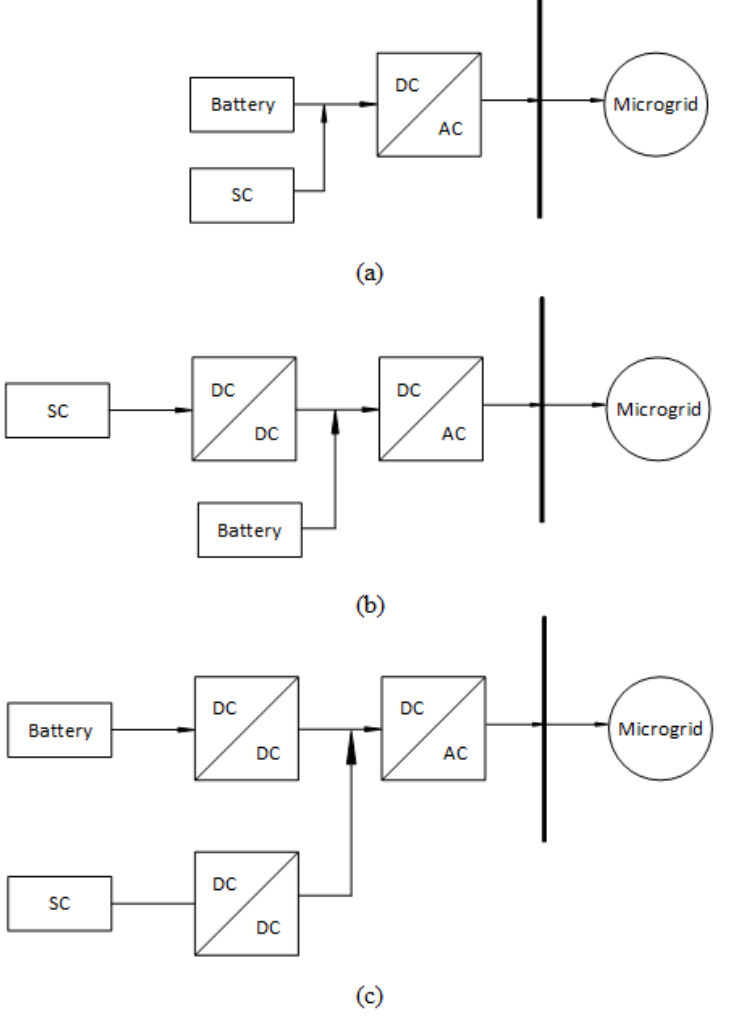
Figure 9. Supercapacitor + battery hybrid topologies used in microgrids ( a ) passive topology, ( b ) semi-active topology, and ( c ) active topology [51].